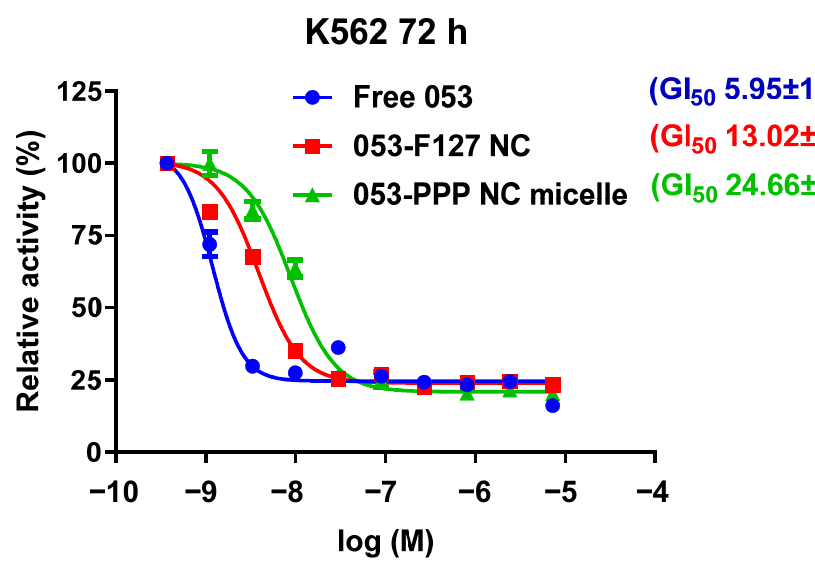
Figure 4. Cell viability/cytotoxicity of free 053, 053-F127 NC, and 053-PPP NC micelle in K562.